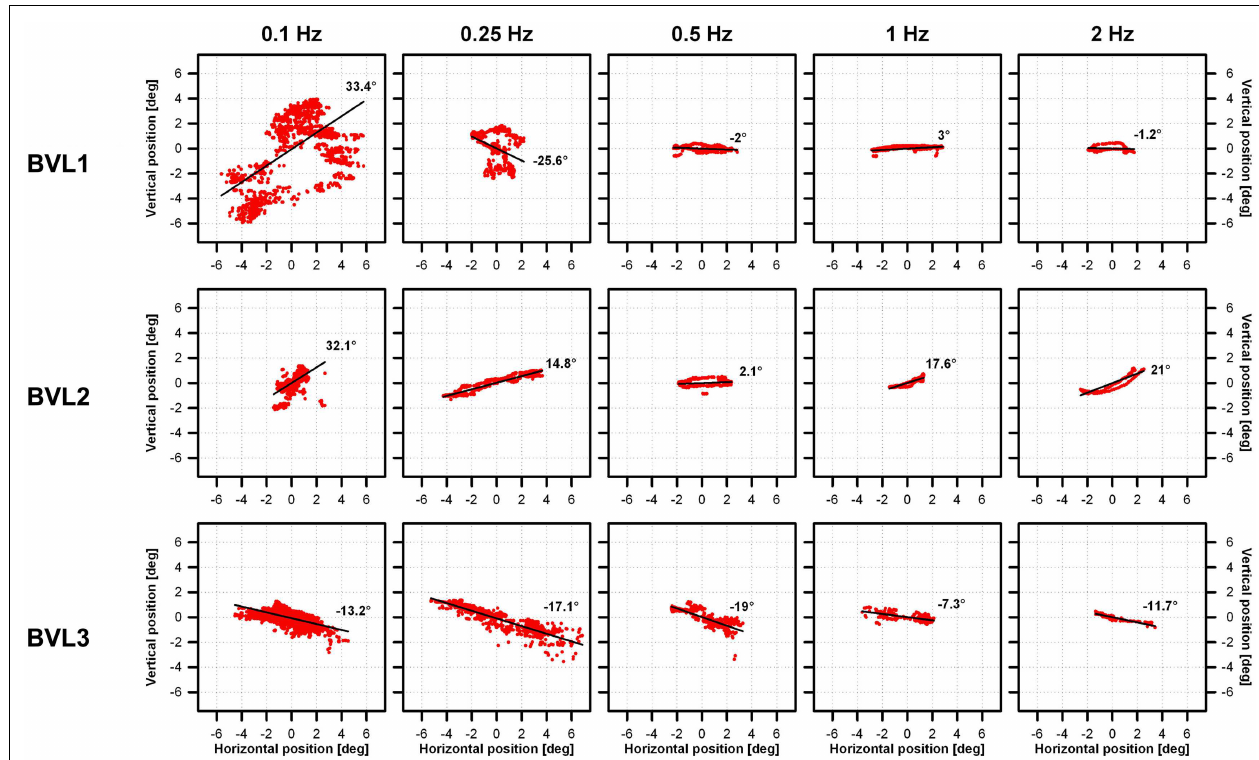
eye dispersion was observed for the lower frequencies and the linear fits were not representative of the direction of eye movements.This was expected since theVOR response at these frequencies was almost absent and in these cases eye movement patterns were mainly random due to the long duration of cycles at these frequencies (e.g., 10s for 0.1Hz rotations). Otherwise eye movements were predominantly horizontal (maximum deviations of 2°, 21°, and 19° for BVL1, BVL2, and BVL3, respectively), and the axis remained almost the same despite the rotation frequency